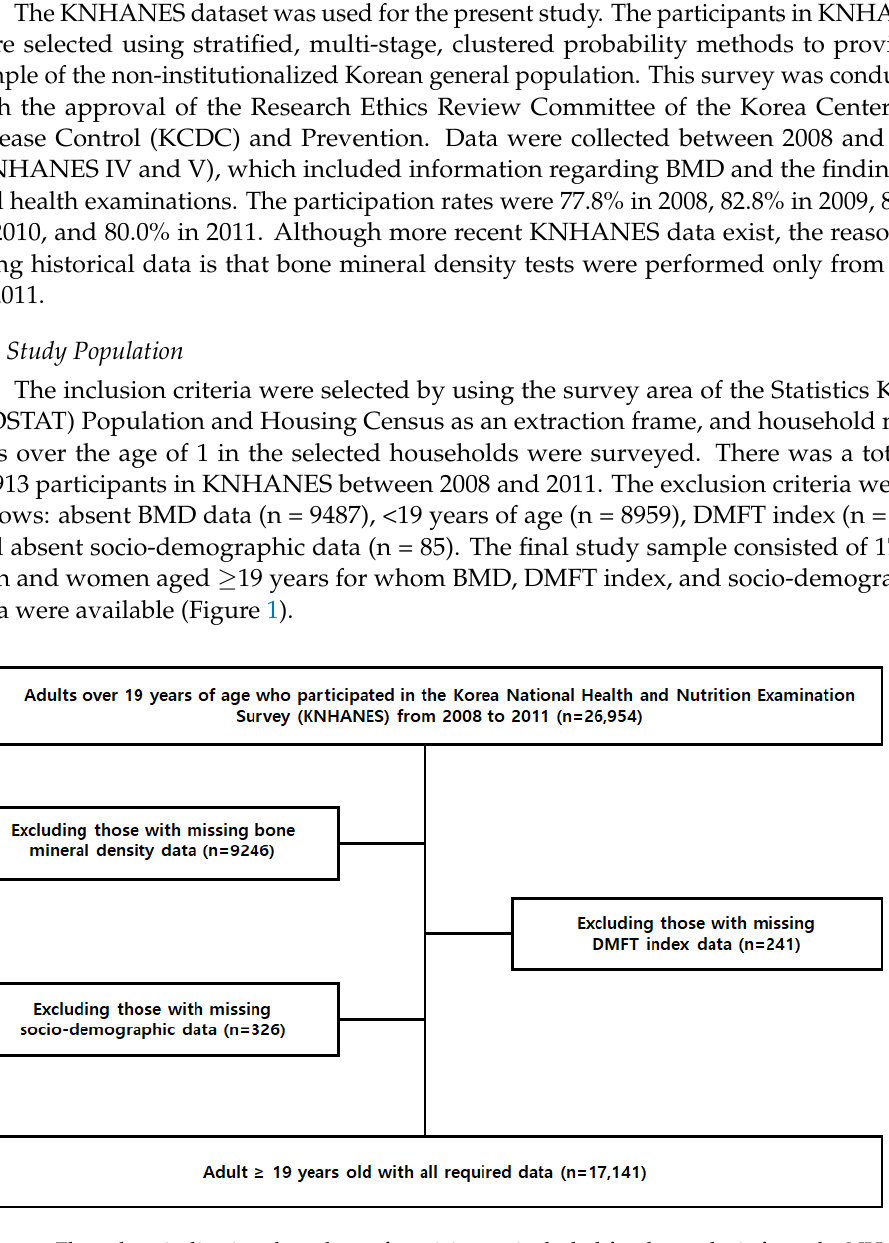
Figure 1. Flow chart indicating the subset of participants included for the analysis from the NHANES 2008–2011